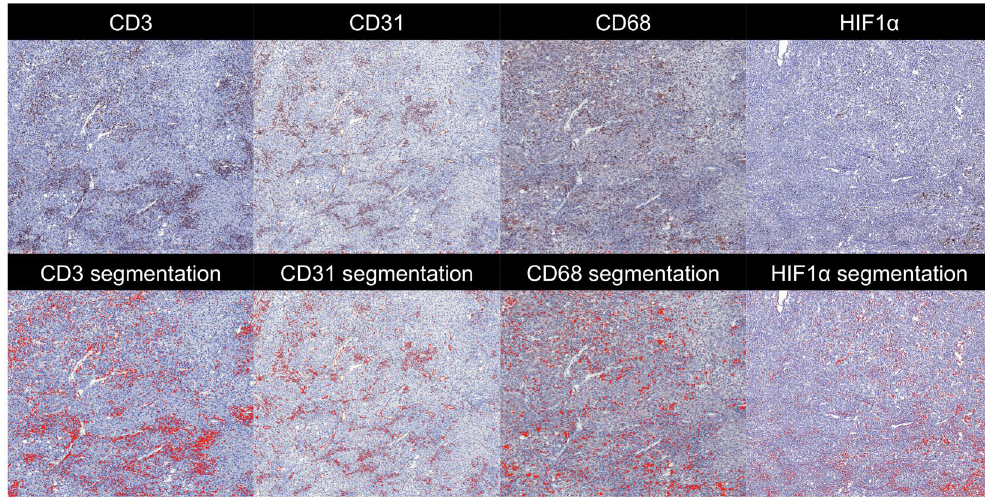
Figure 1. Histopathology processing of HCC sections obtained from a 70-year-old male patient with NASH cirrhosis and HCC. Zoomed microscopy images ( × 20) of an HCC section stained using Multiplexed Immunohistochemical Consecutive Staining on Single Slide (MICSSS) for CD3, CD31 and CD68 and a separate section stained for HIF1 α are shown in the top row. Results of the automatic segmentation algorithm are shown in the bottom row, in which pixels identified as stained are coloured in red. CD3 = cluster of differentiation 3, CD31 = cluster of differentiation 31, CD68 = cluster of differentiation 68, HIF1 α = hypoxia-inducible factor